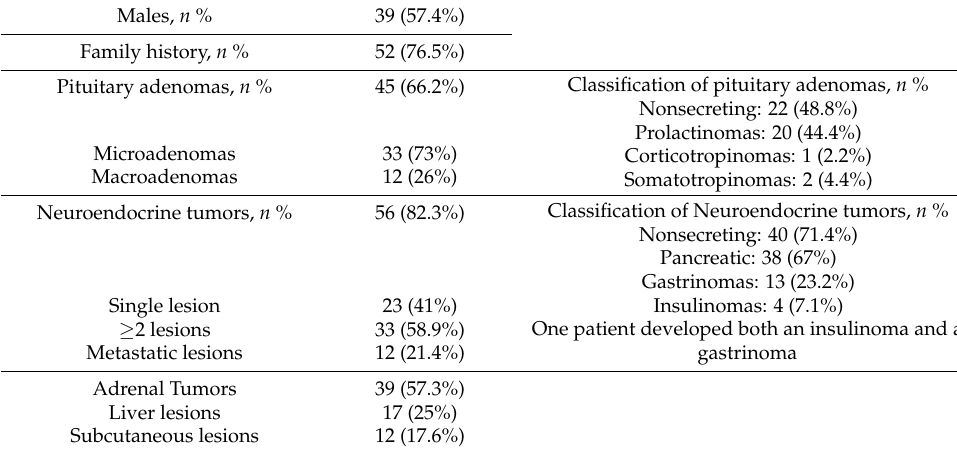
Table 1. Clinical characteristics of the patients’ cohort ( n =